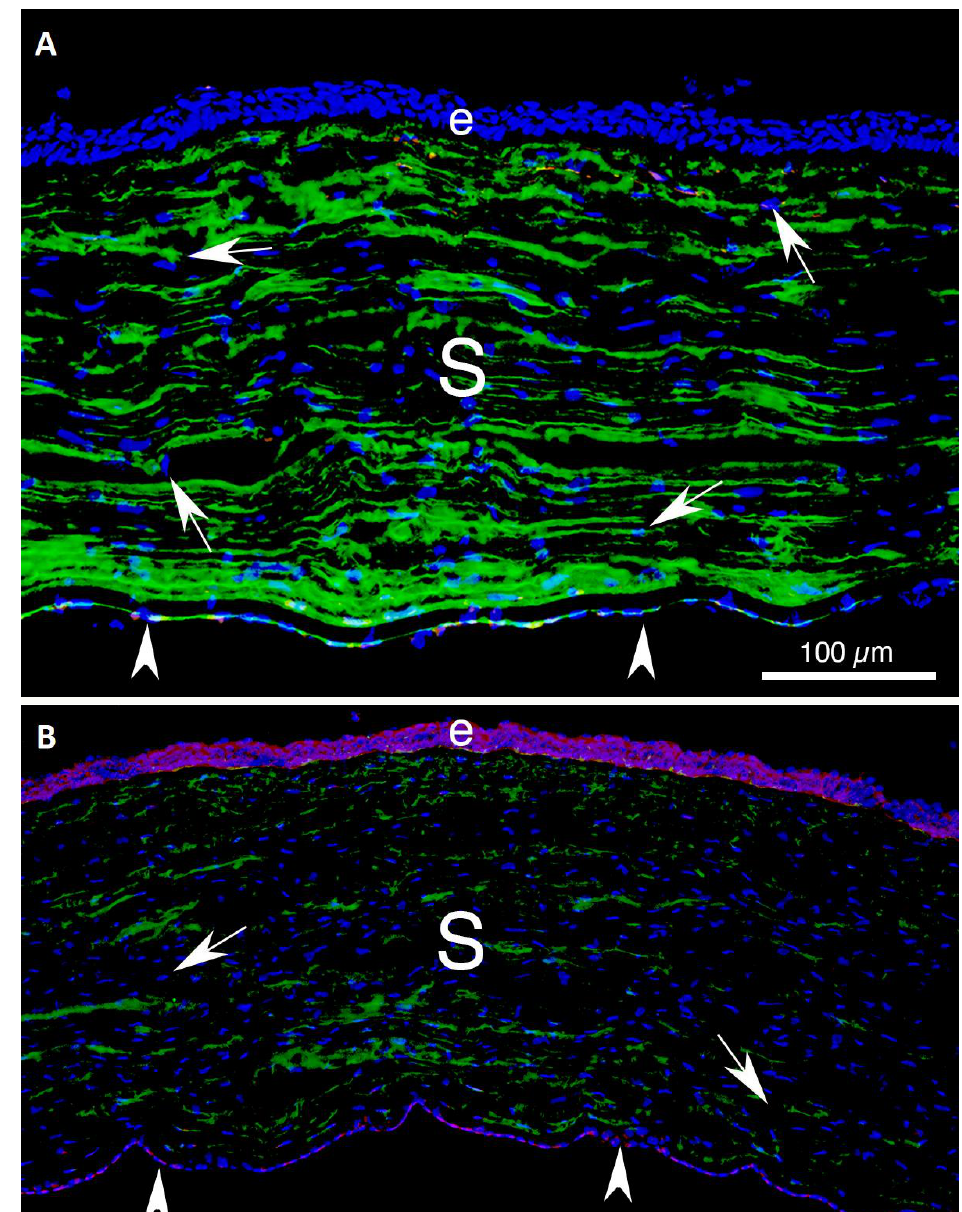
Figure 2. Structure of the cornea. ( A ) A transverse section of an unwounded rabbit cornea that had immunohistochemistry (IHC) for keratocan (green) and alpha-smooth muscle actin ( α -SMA) (red), along with DAPI (blue) stained nuclei. e is the epithelium. Arrowheads indicate the corneal endothelium that lines the posterior surface of the cornea. The central stroma (S) comprises approximately 95% of the corneal thickness and is populated primarily with keratocytes (arrows), although a few resident immune cells and nerves are also present (not shown). No α -SMA cells were detected. ( B ) An unwounded rabbit cornea that had IHC for TGF beta-1 (pink) and keratocan (green). Keratocan is present throughout the (S) and associated with keratocytes (arrows). Note that in the unwounded cornea, TGF beta-1 is detected in the epithelium (e) and the corneal endothelium (arrowheads), with little, if any, detected in the corneal stroma. Reprinted with permission from Ref. [8]. Copyright 2021 Elsevier.